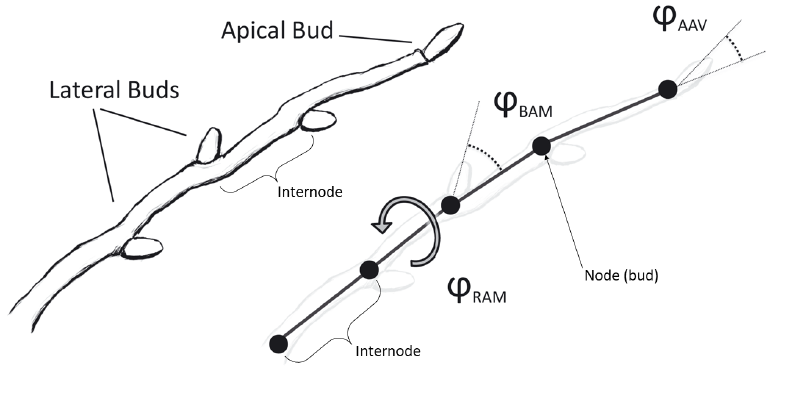
Figure 5. Nodes-internodes scheme of a branch with branching angles. ϕ RAM is the bud rotation angle around internode axis; ϕ BAM is the bud angle to internode axis; ϕ AAV is the apical bud angle to internode